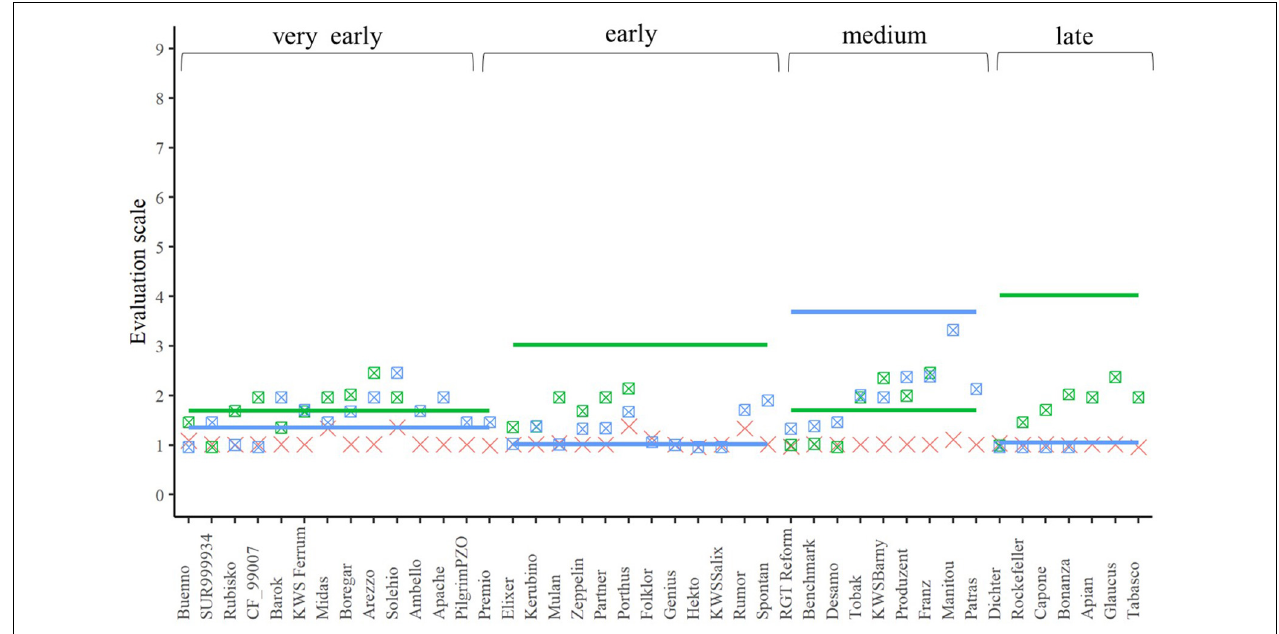
FIGURE 4 | The best linear unbiased estimations of the female (cross), male (line), and their corresponding hybrids (square with cross) for lodging tolerance. The horizontal bars represent the males in each flowering time group. The males and their offspring have the same color.